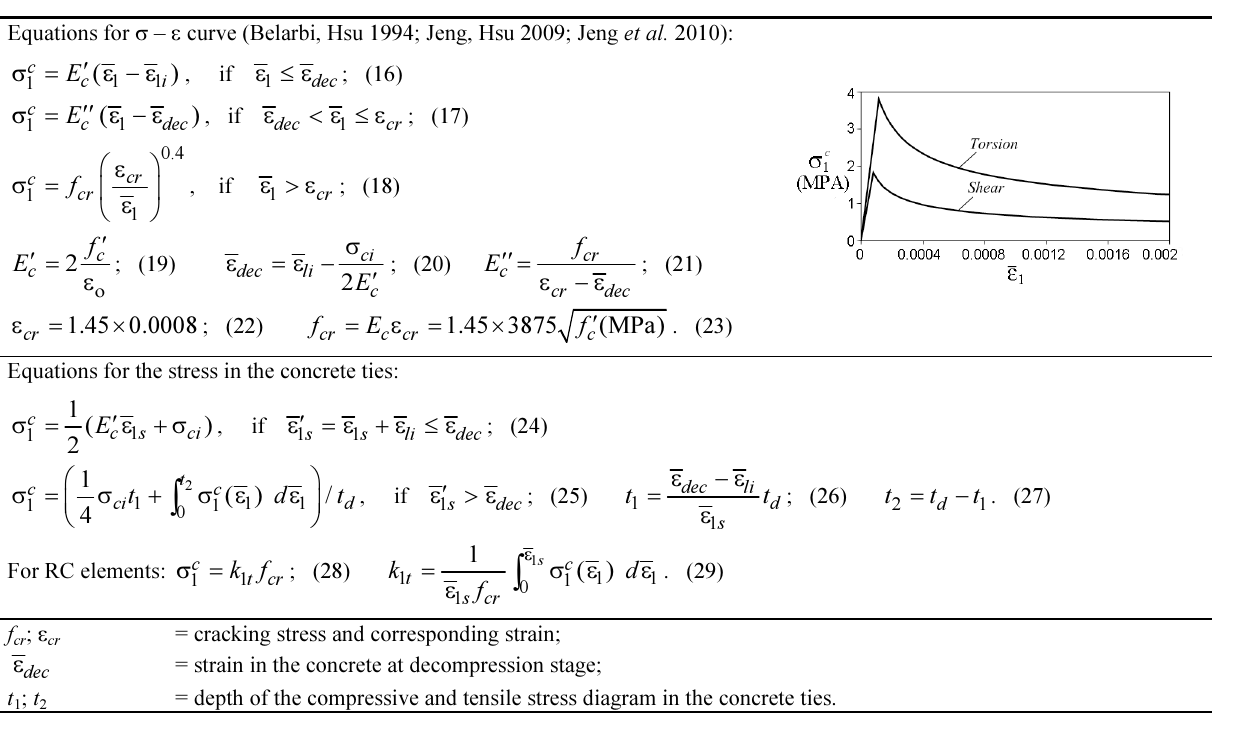
Table 3. σ – ε relationship for concrete in tension for PC beams (for RC beams: 0 dec li ε = ε = )